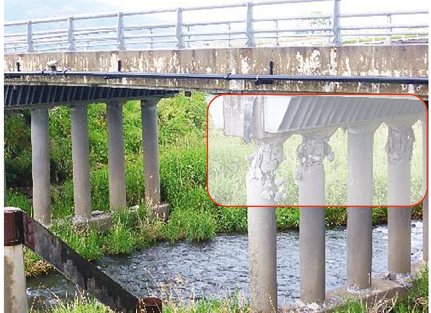
Figure 5: Damage to the tops of the piers of Hatanaka Dai-ichi Bridge.